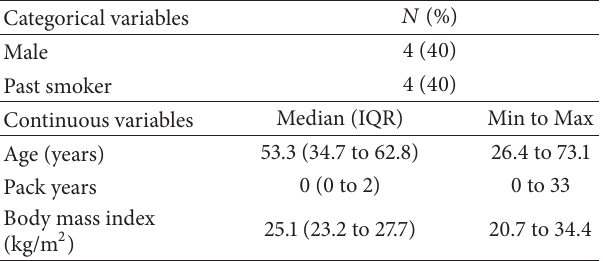
Table 1: Participant